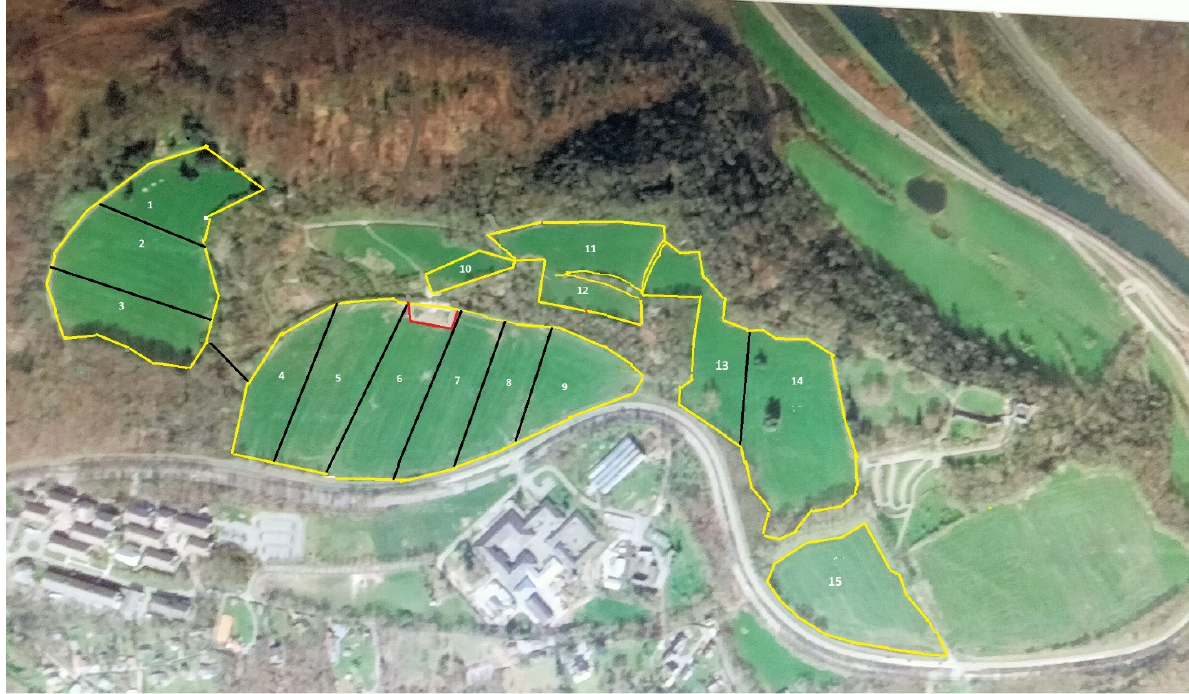
Figure 1. Paddocks layout. Twenty-four ha of pastures are divided into 15 paddocks ranging from 0.6 to 3.3 ha. Cows were allocated to the day (P7–P15) and night paddocks (P1–P6) by passing through a selection gate. In red; the position of the milking unit.